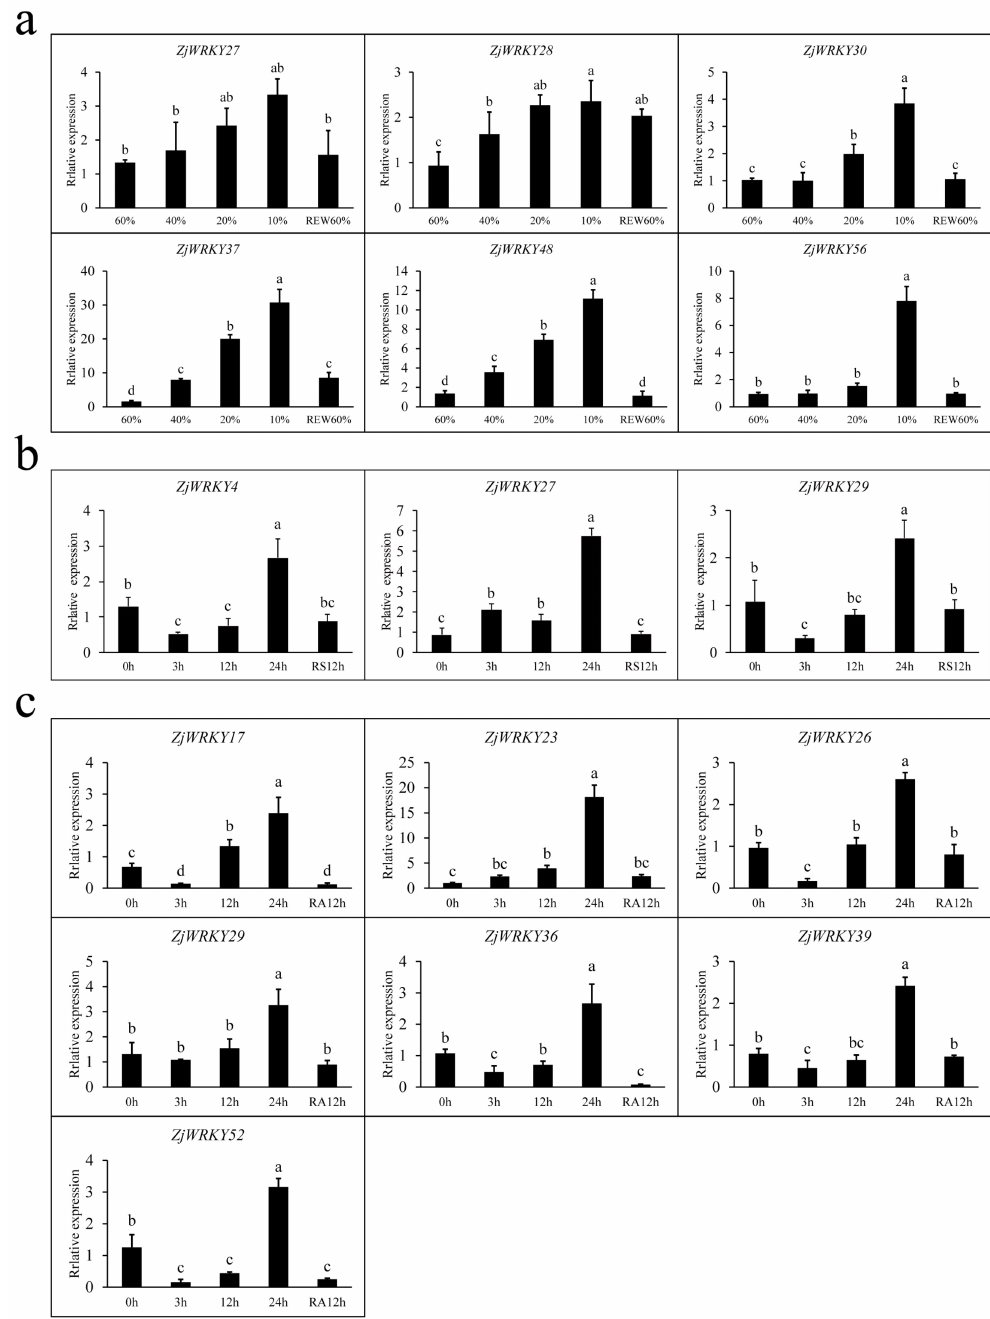
Figure 9. Expression profile of the ZjWRKY genes under three treatments. ( a ) Expression level of 6 ZjWRKY genes in soil moisture content 60%, 40%, 20%, 10%, and 60% after re-watering (REW60%); ( b ) Expression level of 3 ZjWRKY genes under 0 h, 3 h, 12 h, and 24 h NaCl treatment, and 12 h removal of NaCl (RS 12 h); ( c ) Expression level of 7 ZjWRKY genes after 0 h, 3 h, 12 h, and 24 h of ABA treatment, and 12 h after removal of ABA (RA 12 h). The histograms represent the relative expression level of ZjWRKY genes compared to the reference. Error bars represent standard deviations. The data were calculated using the method of 2 - ∆∆ Ct . LSD detection was used to label di ff erent letters when there was a significant di ff erence in expression ( p < 0.05; n =